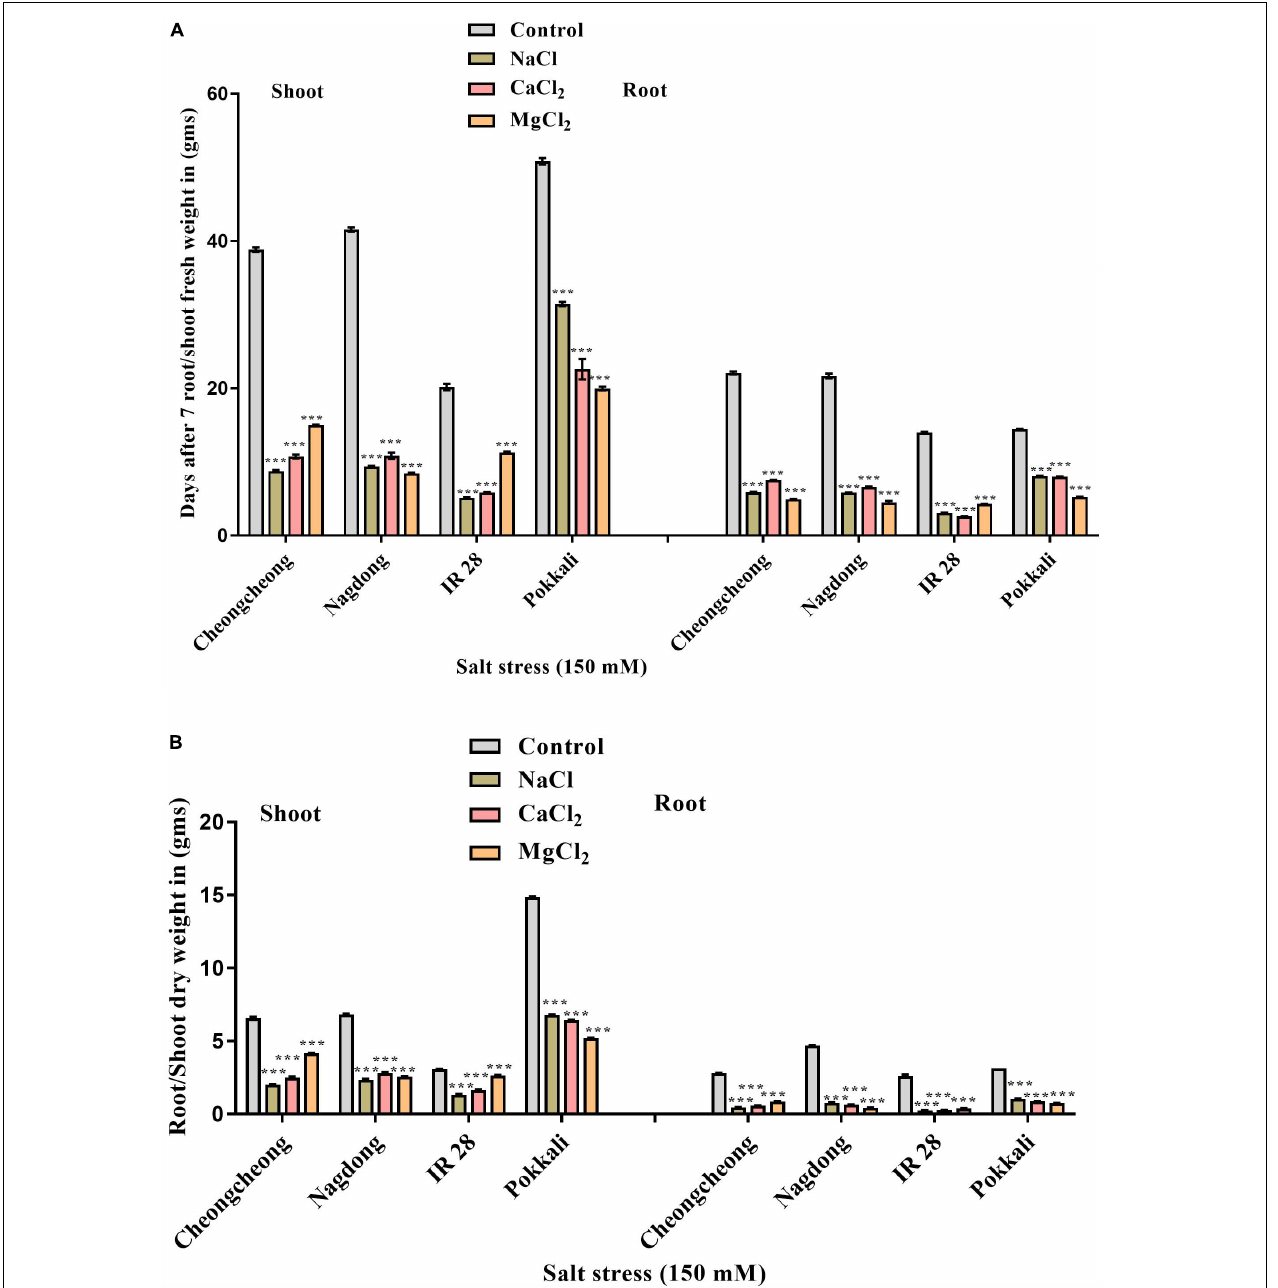
FIGURE 3 | Effect of 150 mM of different salts on the shoot and root fresh and dry weight. (A) Fresh weight of shoots and roots. (B) Shoot and root dry weight. Statistical analysis was calculated by the Bonferroni posttest two-way repeated-measures analysis of variance. Asterisks in the vertical bar indicate a significant difference at *** p < 0.00, compared to